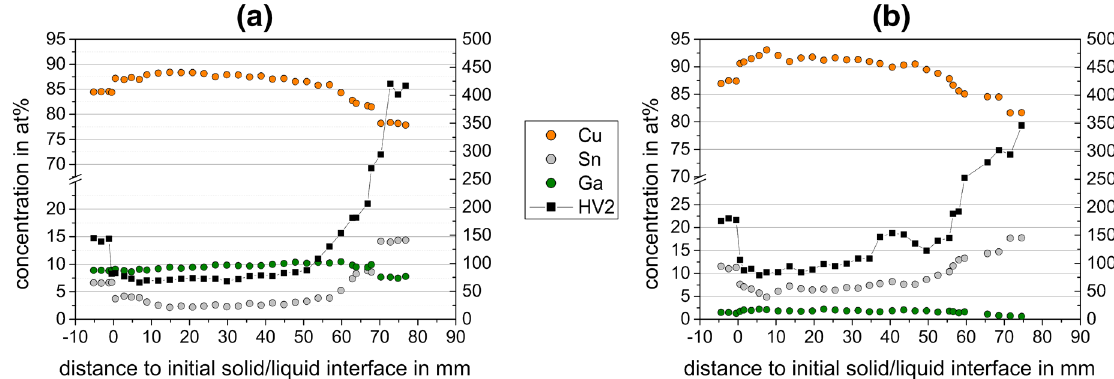
Figure 3. Composition and Vickers hardness HV2 change at positions relative to the initial solid/liquid interface of ( a ) Cu 84.5 Ga 9.5 Sn 6 and ( b ) Cu 87 Ga 2 Sn 11 . Targeted comp. Measured comp. Sample (at%) (at%)